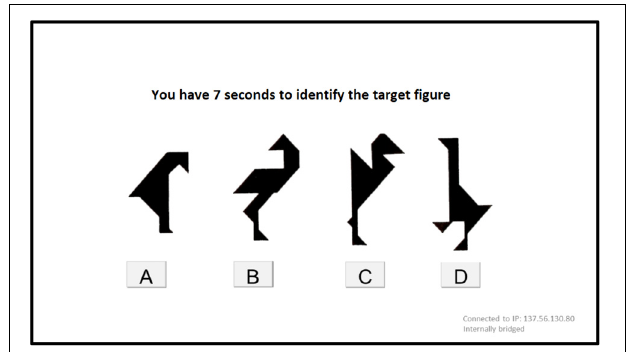
FIGURE 3 | An array of tangram figures presented to participants in one of the